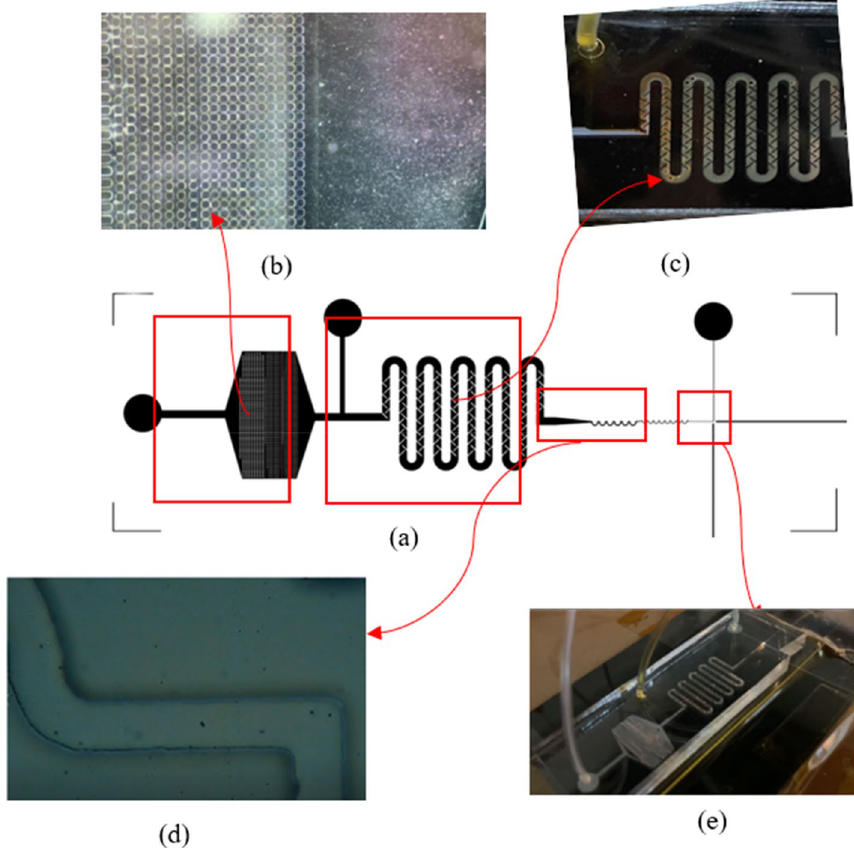
Figure 5. Microfluidic device for somatic cell classification. ( a ) Microfluidic device ( b ) somatic cells filter ( c ) somatic cells mixer ( d ) alinement of somatic cells to detection area ( e ) Detection